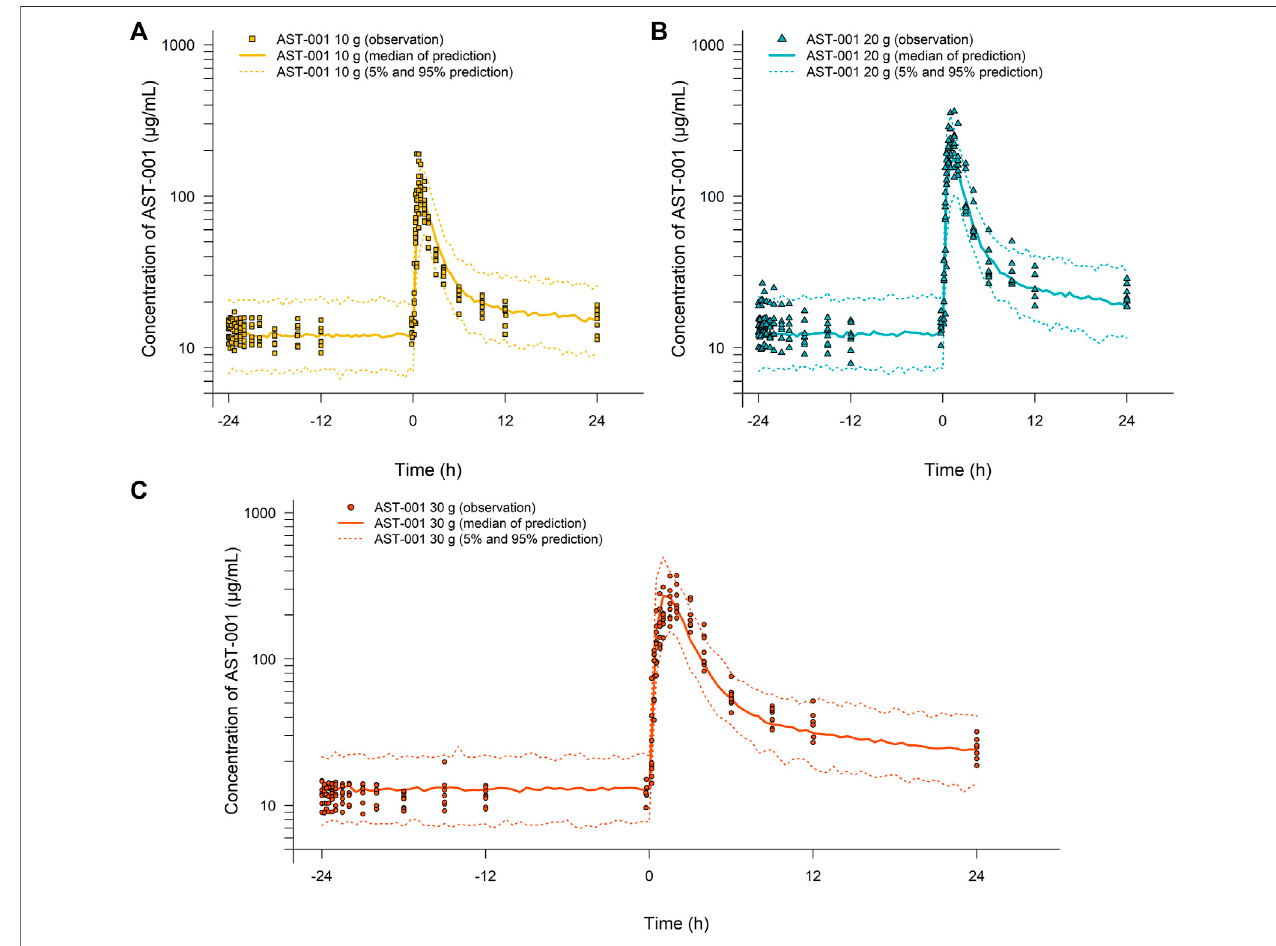
FIGURE 3 | Simulation results for the time-concentration pro fi le of AST-001 before and after a single administration of (A) 10 g, (B) 20 g, or (C) 30 g of AST-001 overlaid with individual observations in healthy subjects. Line and dotted line indicate median, 5 and 95% prediction intervals, respectively.